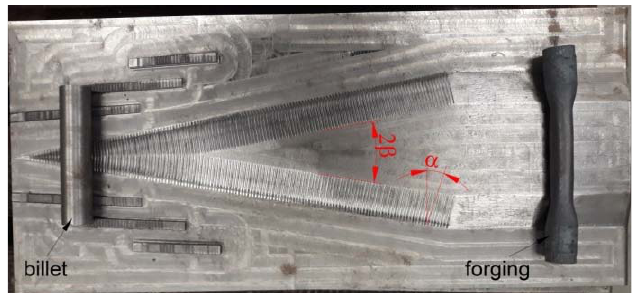
Figure 1. The wedge tool used in the experimental study.